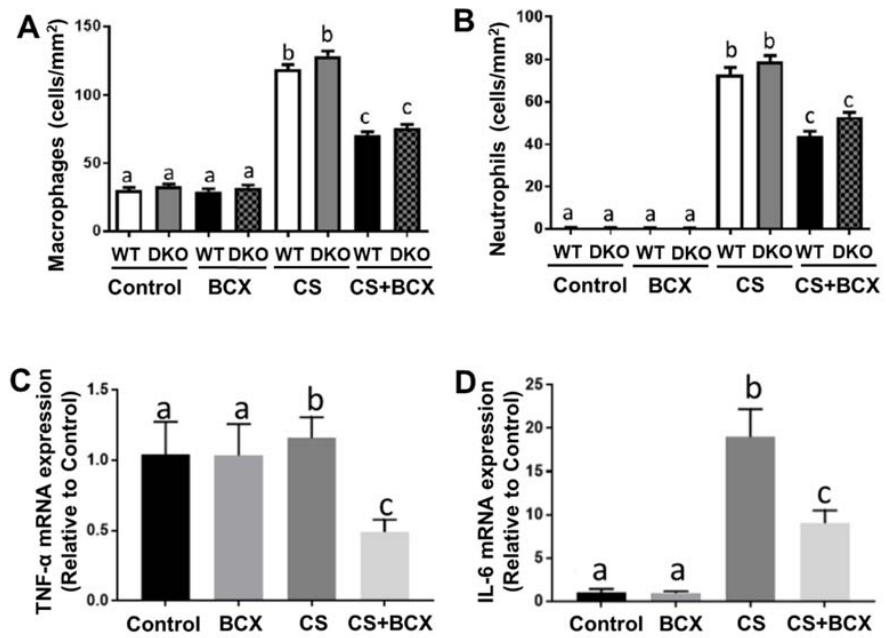
Figure 3. BCX feeding significantly prevented inflammation in the lung of WT mice and BCO1 − / − /BCO2 − / − DKO mice exposed to CS. ( A ) Quantification of H&E stained (at 10 × ) lung pathology of macrophage accumulation, and ( B ) neutrophil accumulation in the lungs of WT and DKO mice. ( C ) Shown are the graphical representations of mRNA expression of C) TNF- α and ( D ) IL-6 quantified by real-time PCR in the lungs of DKO mice ( n = 7–9 for each group). β -actin was used as a loading control. Groups: Control, non-CS-exposed mice without supplementation; BCX, non-CS-exposed mice with BCX supplementation; CS, CS-exposed mice without supplementation; CS+BCX, CS-exposed mice with BCX supplementation. Lung inflammation, macrophages, and neutrophils were quantified in the alveoli for 10 fields at a magnification of 400 × (1.59 mm 2 ) for each animal; and the number of macrophages or neutrophils is expressed as cells/mm 2 . Significant differences between groups were analyzed by one-way ANOVA and are denoted by different letters (signifi-